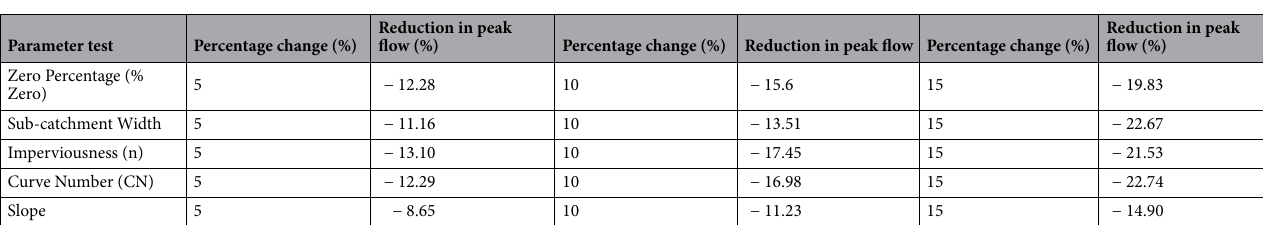
Table 4. Sensitivity analysis results of SWMM